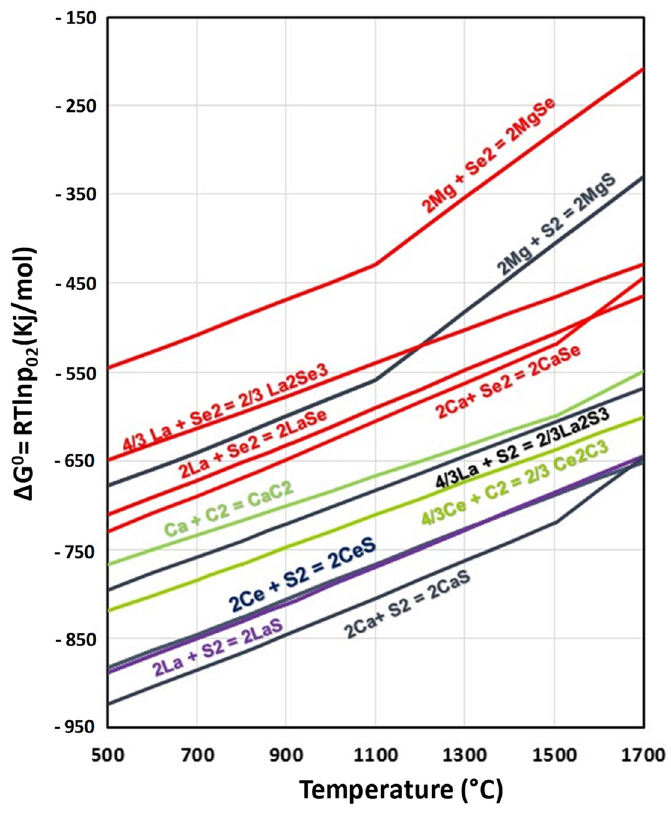
Figure 9. Standard free energy of formation of some selected sulfides and selenides.